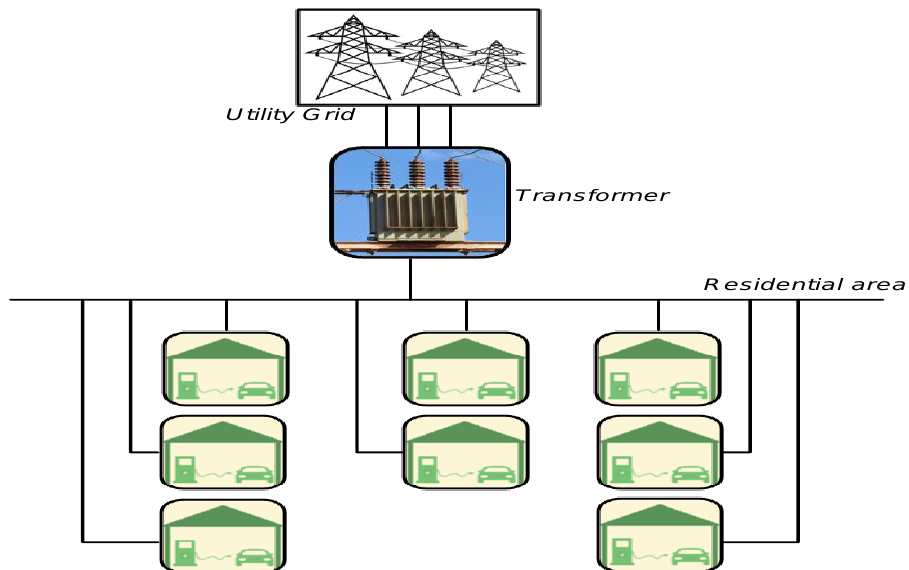
Figure 1. Distribution transformer serving residential loads.